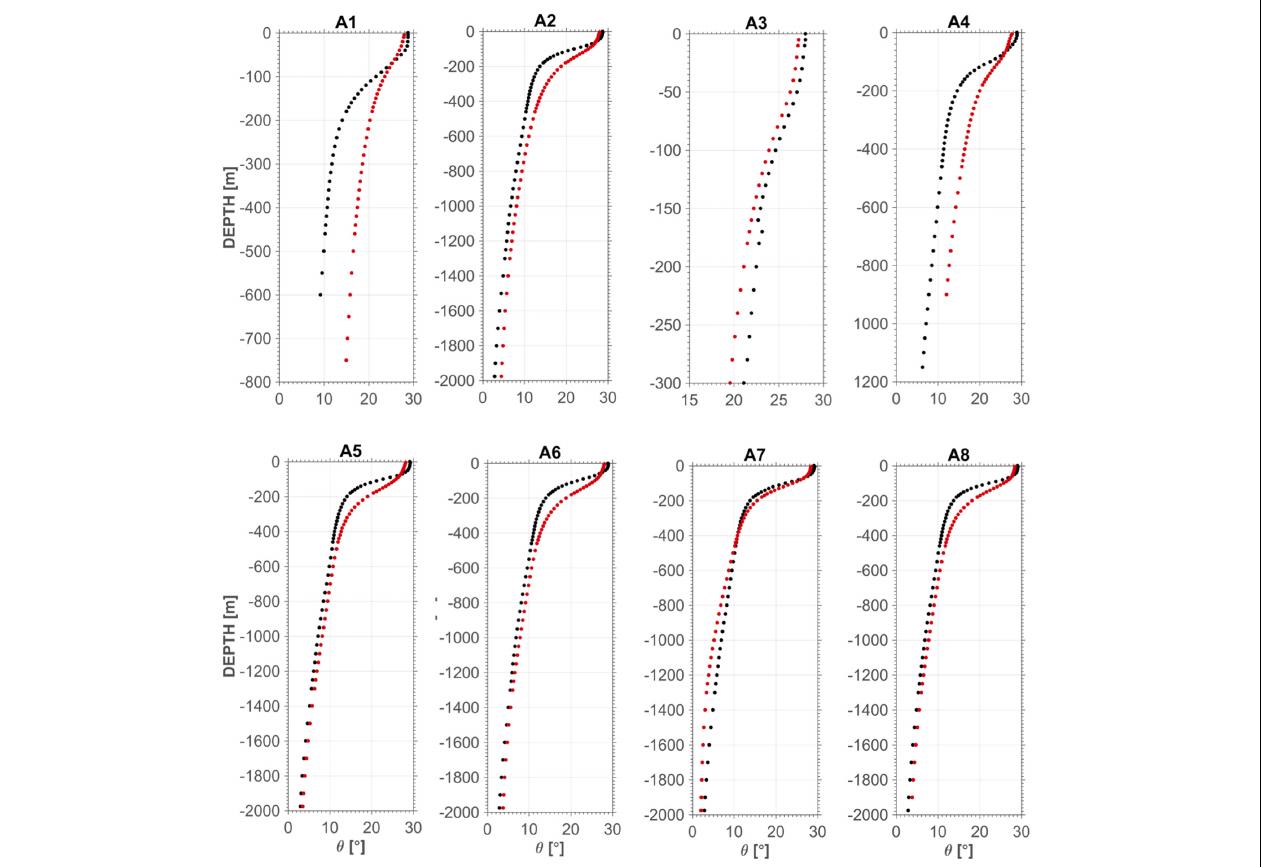
FIGURE 6 | Comparison of Argo (black) and SNIO (red) climatological monthly mean temperature profiles at eight locations identified around Maldives and Sri Lanka (see Figure 2 ). Note that the y-axis are at different